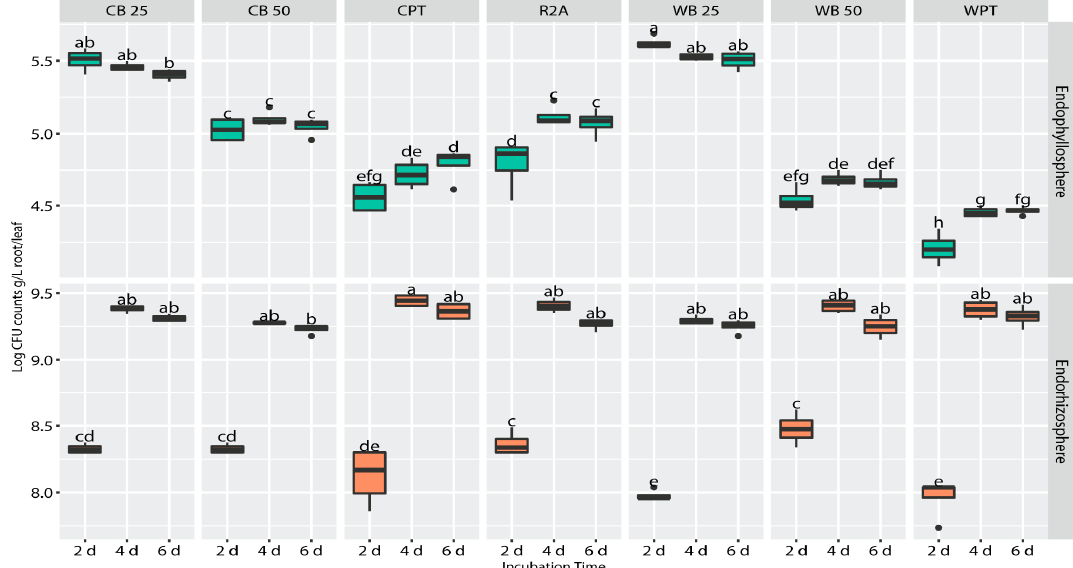
Figure 3. Cultivability of clover endophytes on culture media prepared from homologous (clover) and heterologous (wheat) plant broths: Two-way ANOVA analysis for cultivable endophytic bacteria of rhizosphere (orange) and phyllosphere (green) of clover plant plotted along 3 incubation times (2, 4 and 6 days); cultivations were on homologous clover broth (CB 25, 25 mL broth L − 1 ; CB 50, 50 mL broth L − 1 ) and heterologous wheat broth (WB 25, 25 mL broth L − 1 ; WB 50, 50 mL broth L − 1 ) and were compared to cultivation on teabag culture media prepared from dehydrated clover (CPT) and wheat (WPT), as well as standard chemically defined and artificial culture media (½ modified R2A). Statistically significant differences are indicated by different letters ( p value ≤ 0.05, n = 4).